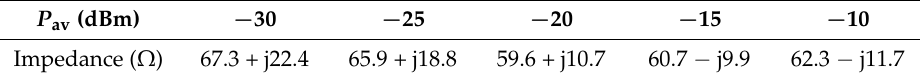
Table 2. Values of the input impedance of the rectenna at 814 MHz using for R o the values of Table 1 . P av (dBm) − 30